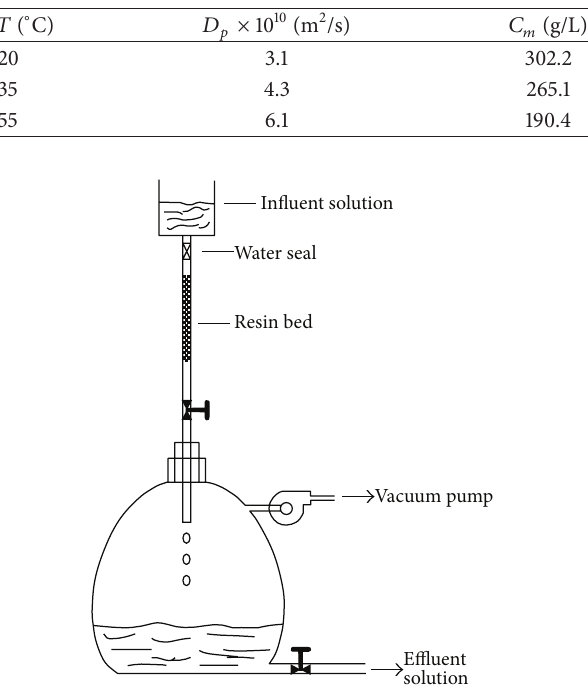
Table 1: Diffusivities and resin saturation capacity at different temperatures [21].